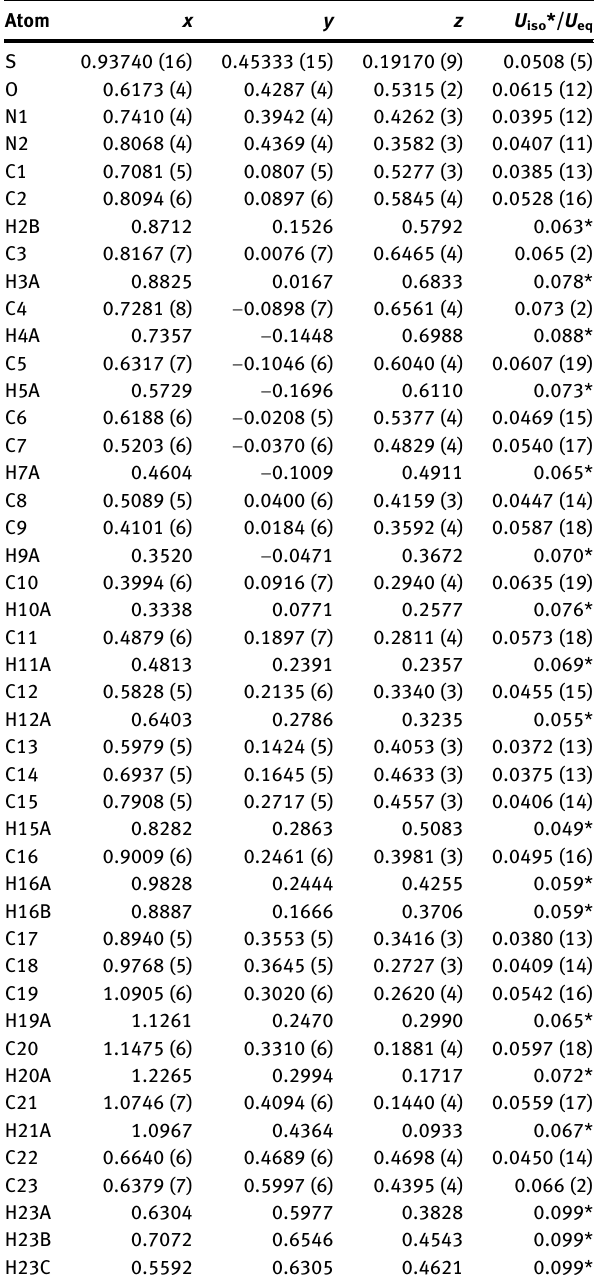
Table  : Fractional atomic coordinates and isotropic or equivalent isotropic displacement parameters (Å 